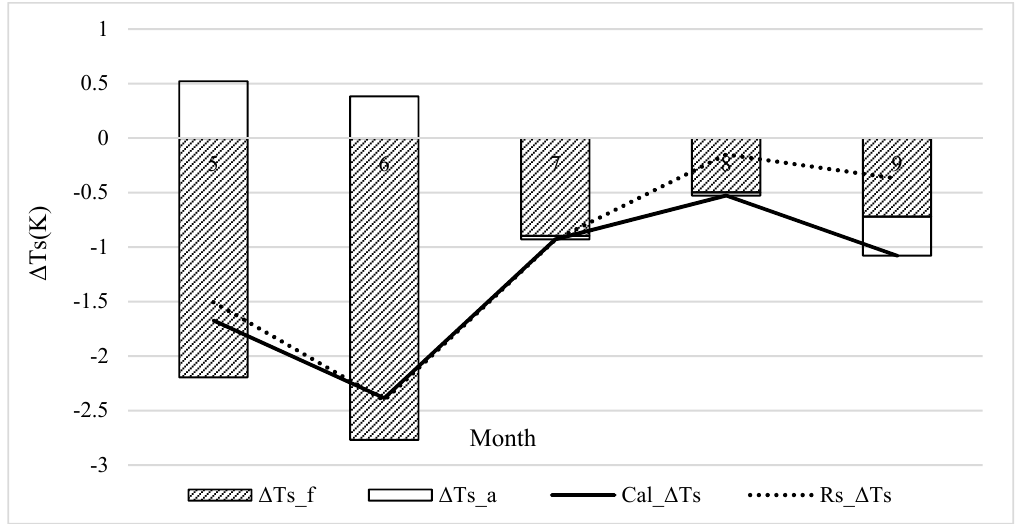
Figure 5. Land surface temperature based on MODIS data (Rs_ Δ Ts ) and Equation (5) (Cal_ Δ Ts ), and contribution from albedo change ( Δ Ts _a) and energy redistribution factor change ( Δ Ts _f), responding to the conversion from rain-fed farmland to paddy fields.